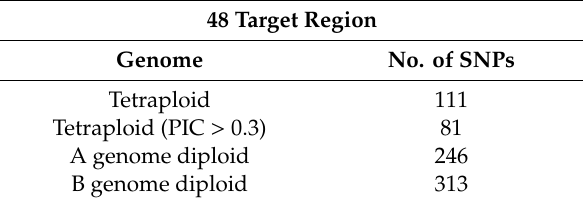
Table 5. Summary of SNPs obtained from MiSeq reads mapped to the 48 targets. 48 Target